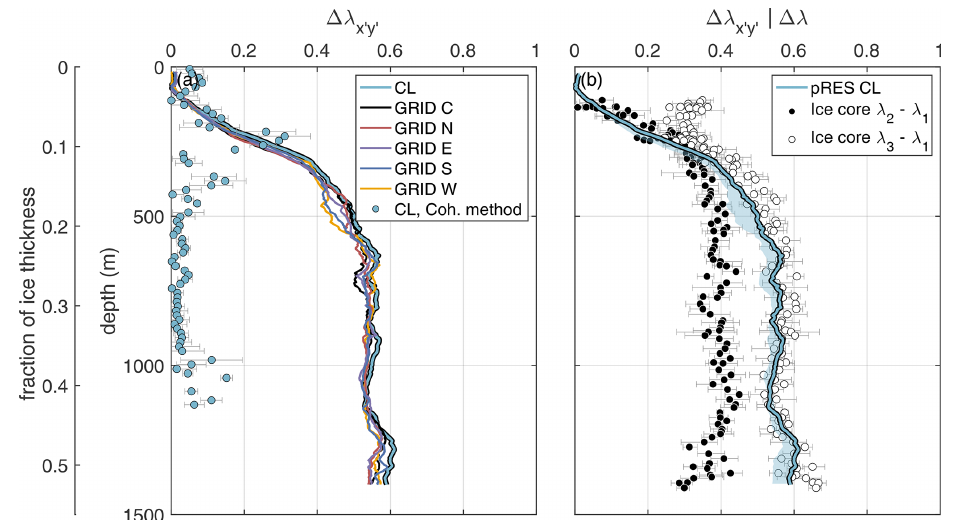
Figure 3. Comparison of horizontal fabric asymmetry (cid:49)λ determined from different measurements and analysing methods. (a) Fabric asym- metry determined from cross-correlation analysis (lines) of pRES measurements at CL (light blue line) and at the 20 × 20m GRID outside drill site as well as from the previous coherence method (Young et al., 2021a) at CL (light blue dots). (b) Fabric asymmetry determined from cross-correlation analysis (lines) of pRES measurements at CL (light blue line) and from weighted horizontal eigenvalues from East- GRIP ice core (black and white dots). The blue-shaded area in (b) marks the range of the polarimetric pRES-derived asymmetry from the measurements in the GRID and at